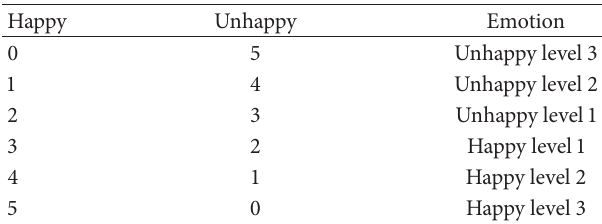
Figure 13: Screenshot of RUNNING game. Table 3: Level of